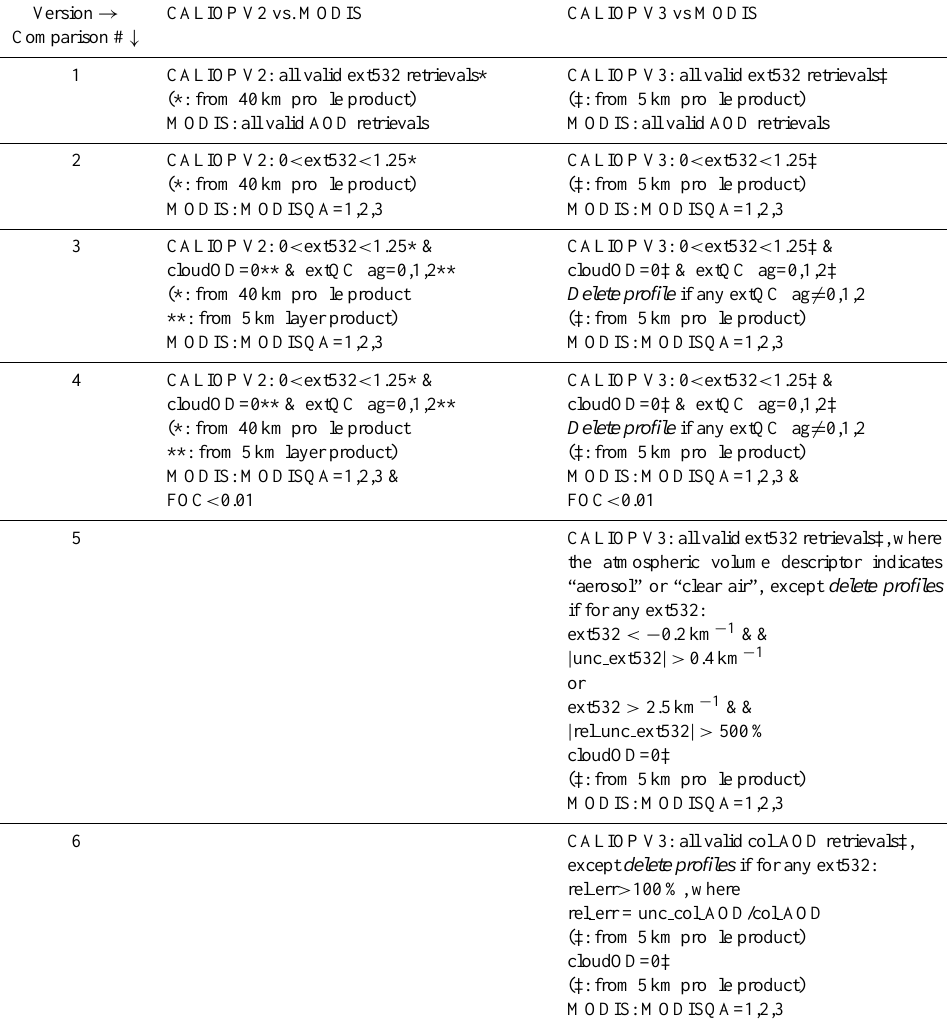
Table 1. Data attributes for different AOD